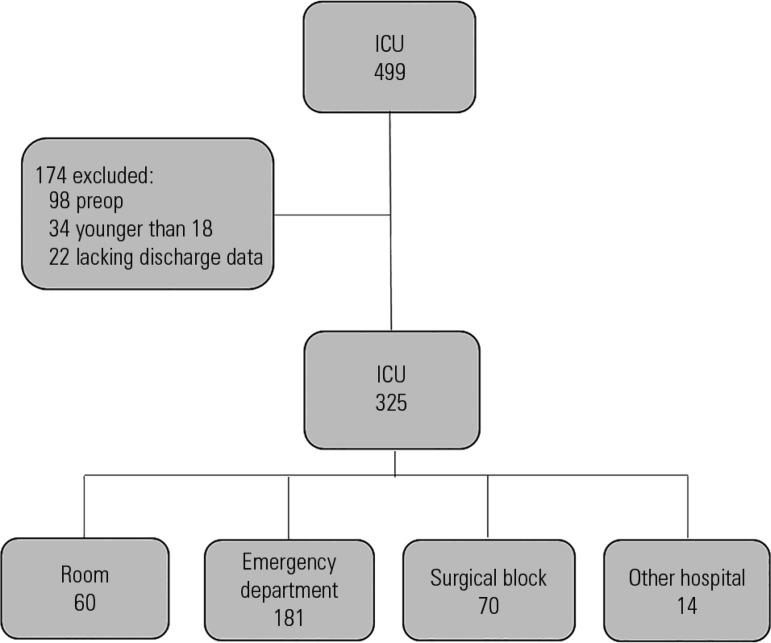
Structure for patient selection.ICU - intensive care unit.